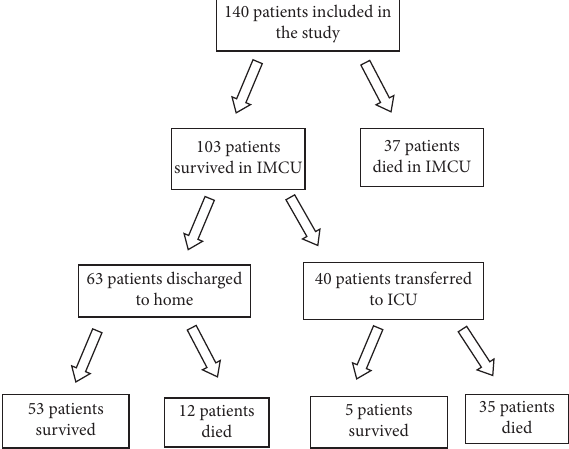
Figure 1: Flowchart of the study. IMCU, intermediate care unit; ICU, intensive care